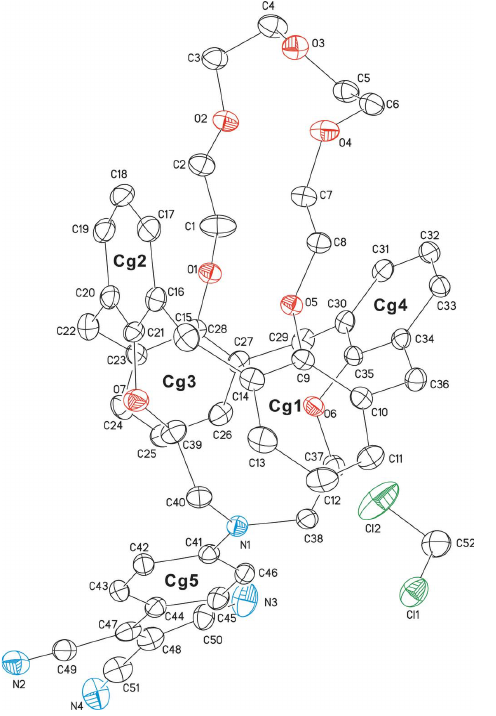
Figure 1 The structure of the title compound with displacement ellipsoids shown at the 30% probability level. H atoms are omitted for